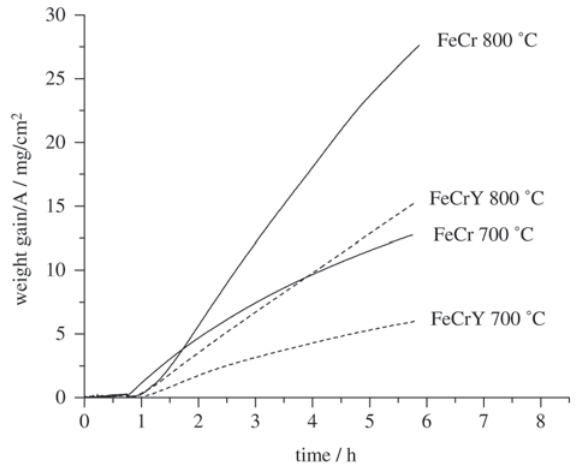
Figure 1. Weight gain versus time curves of FeCr and FeCrY al- loys, sulphidised at 700 °C and 800